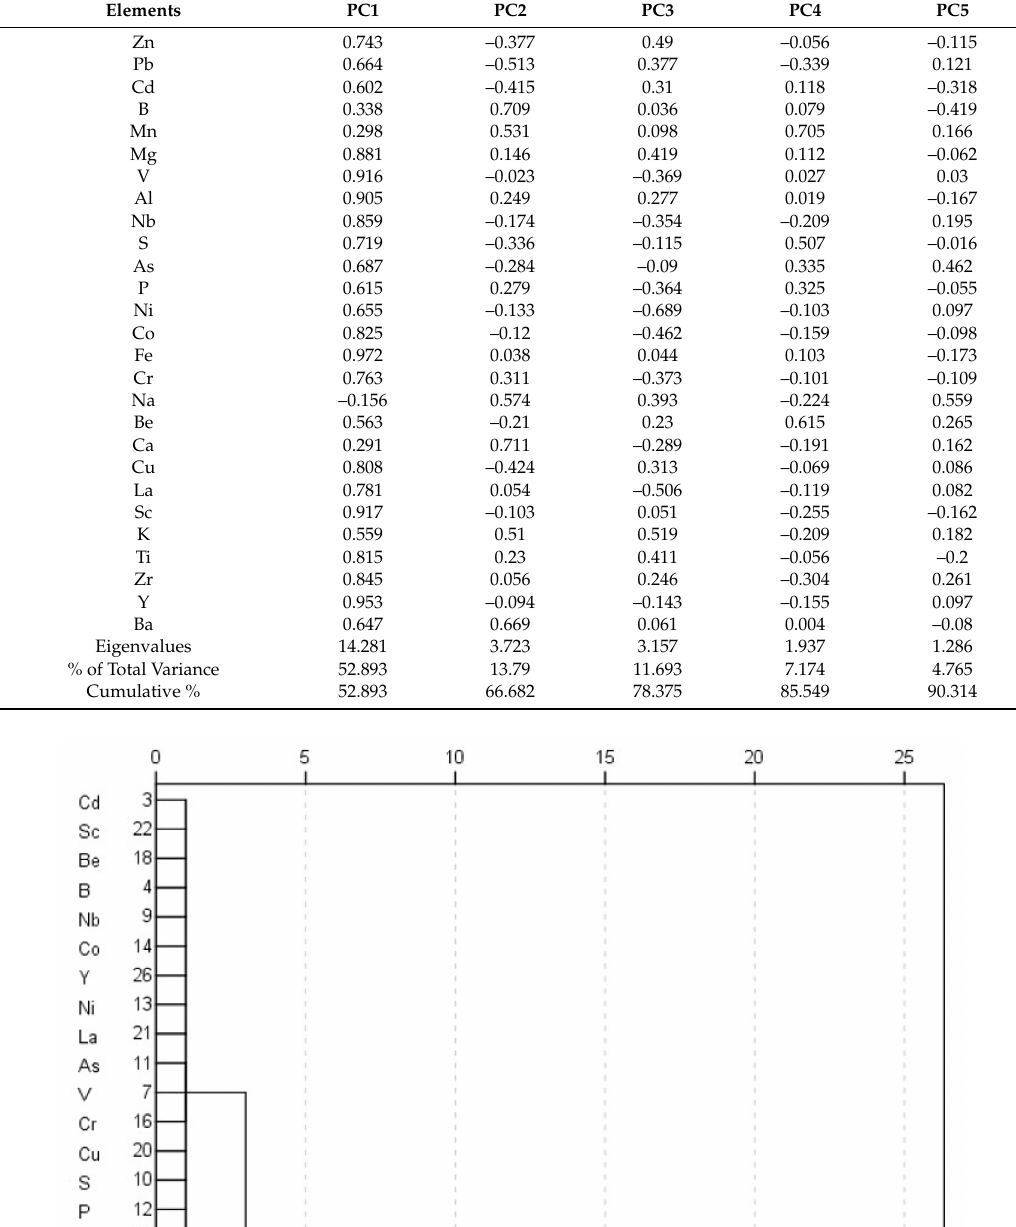
Table 4. Loadings of the elements on Principal Component (PCs) in sediment.